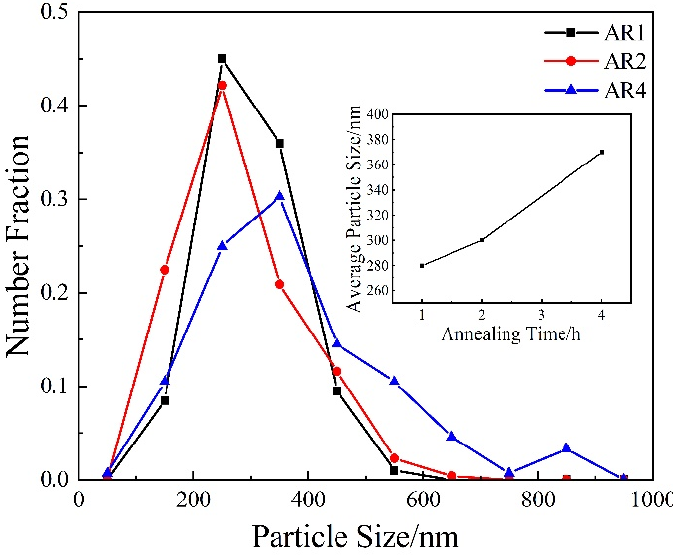
Figure 3. The distribution of cementite particle sizes after annealing at 600 °C for different